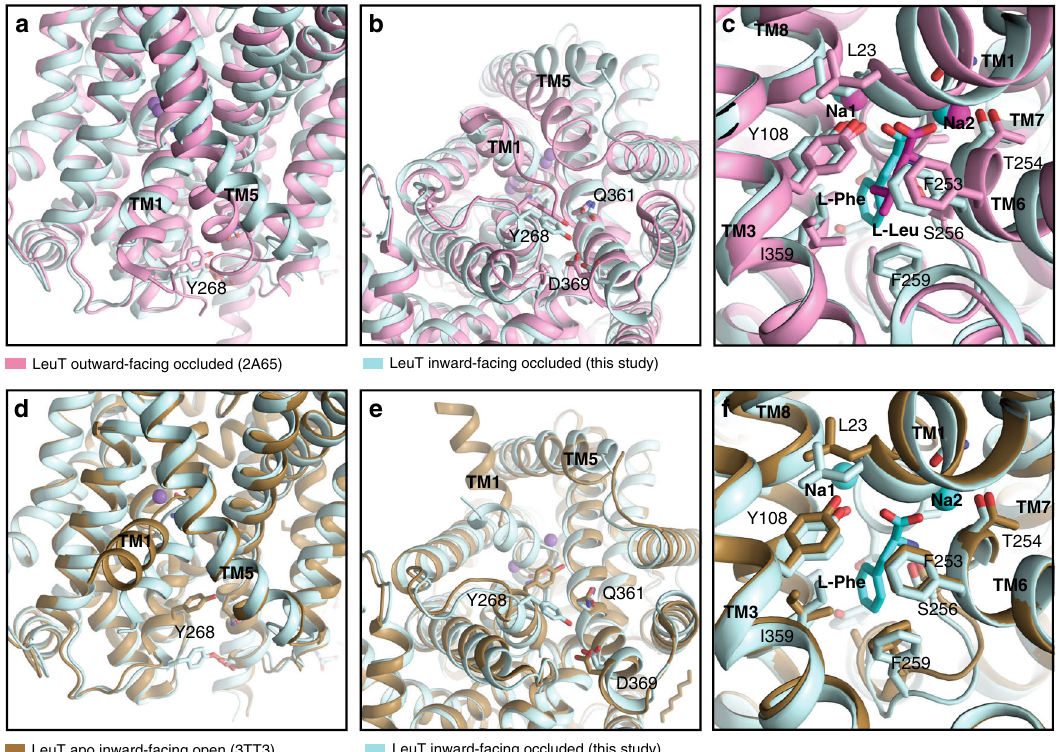
Fig. 5 Comparison of the LeuT W8A structure with LeuT in the outward-facing occluded state and the apo inward-facing open state. a – c Overlay of the LeuT W8A structure in inward-facing occluded conformation (this study; light blue) with LeuT in the outward-facing occluded state (PDB-ID: 2A65 10 ; light pink). a Close-up view of the intracellular vestibule region from the membranous side with transmembrane segments (TMs) 1, 5, and Y268 residue labelled. b Close-up view of the intracellular vestibule from the cytoplasmic side with TM1, 5 and internal gate residues (Y268, Q361, and D369) labelled and shown as colored sticks. c Close-up view of sodium and substrate binding sites with selected coordinating residues labelled and shown as colored sticks. For each structure, two sodium ions are shown as spheres and substrates as darker sticks in the corresponding colors. Residues are selected within a distance of 4 Å. d – f Overlay of the LeuT W8A structure in inward-facing occluded conformation (this study; light blue) with LeuT structure in apo inward- facing open state (PDB-ID: 3TT1 11 ; light brown). Panel presentation is identical as in a – c